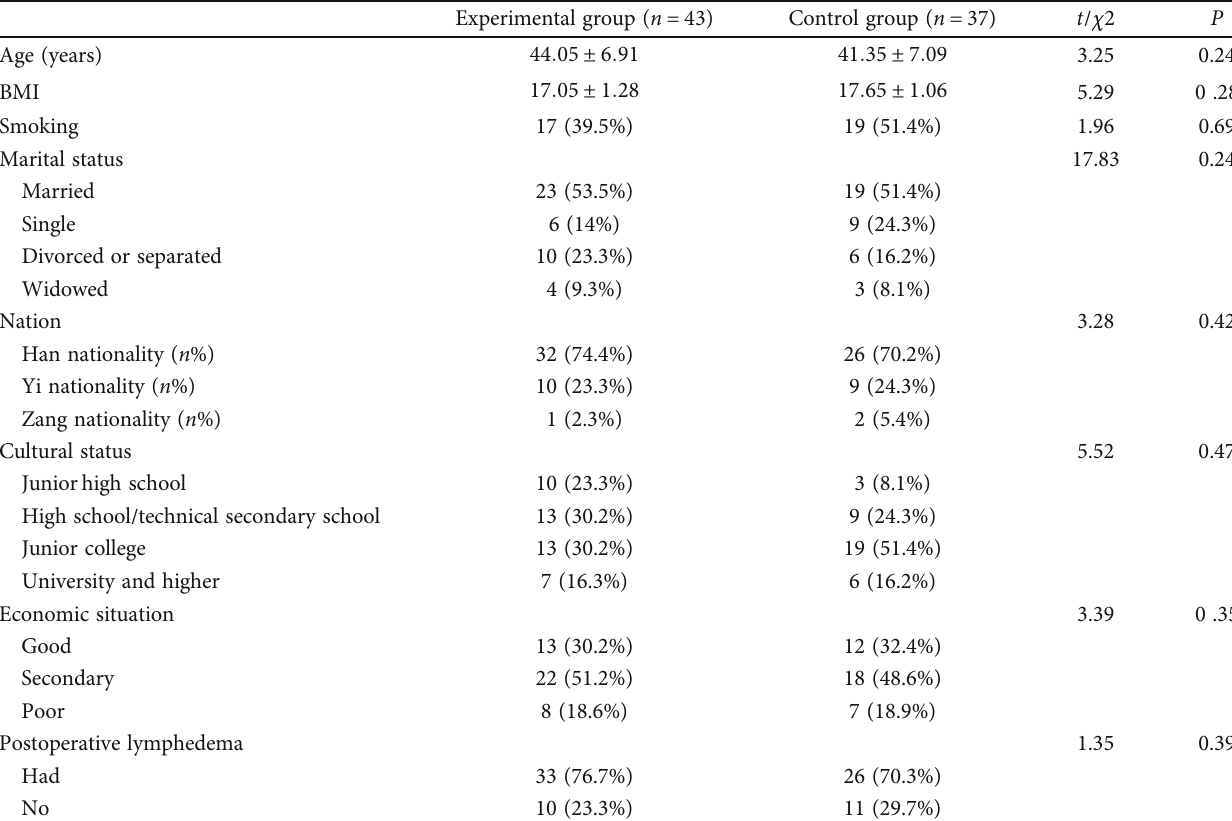
Table 1: Comparison of clinical data between the two groups.